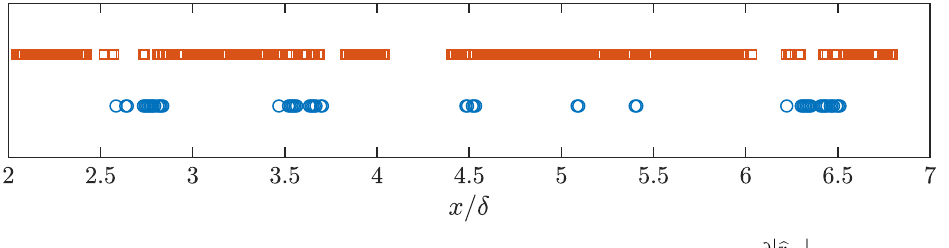
| ∂ | (cid:98) v ω < 0 condition is f ∂ y